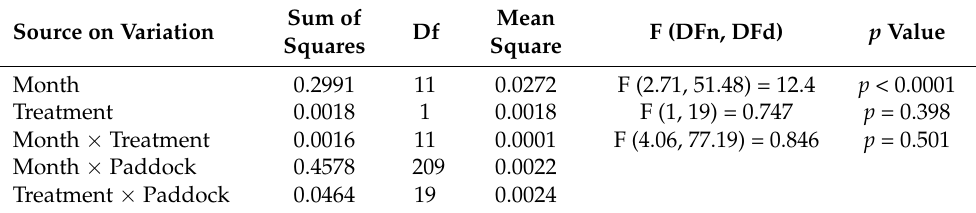
Table A5. Enhanced Vegetation Index (EVI) two-way repeated measure ANOVA of natural grassland, 4 years before to intensification practice, between January and December ( n =